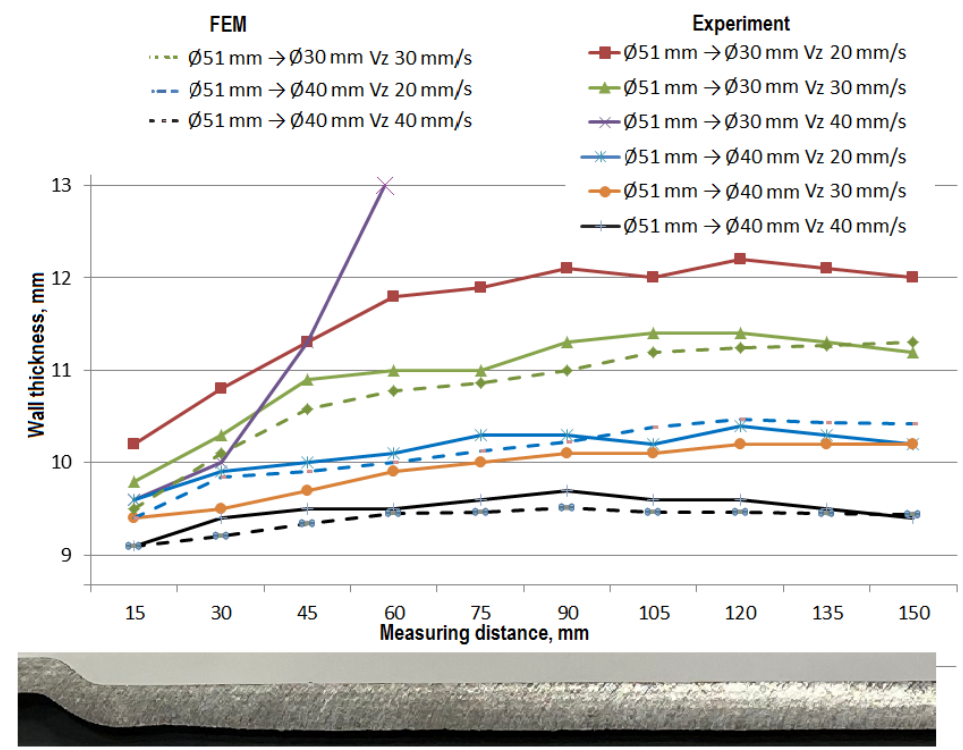
Figure 8. Changes of hollow part wall thickness distributions depending on presented skew rolling process parameters.